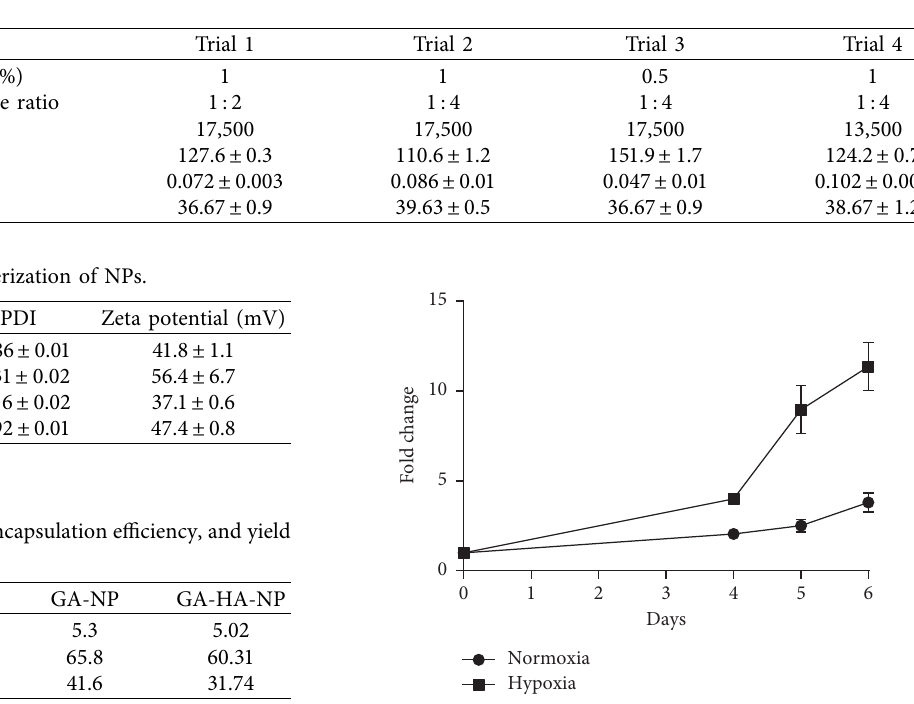
Figure 1: Growth rate (fold changes) of bCSCs maintained under normoxic and hypoxic conditions.